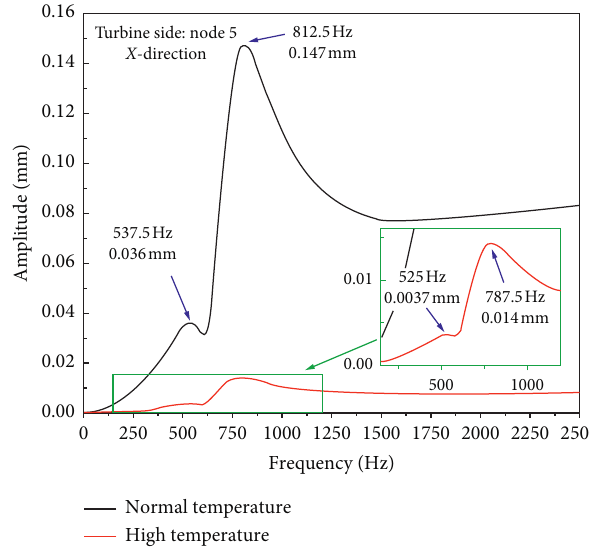
Figure 21: Response comparison between case 1 and case 2 of the turbine side floating ring bearing center position (node